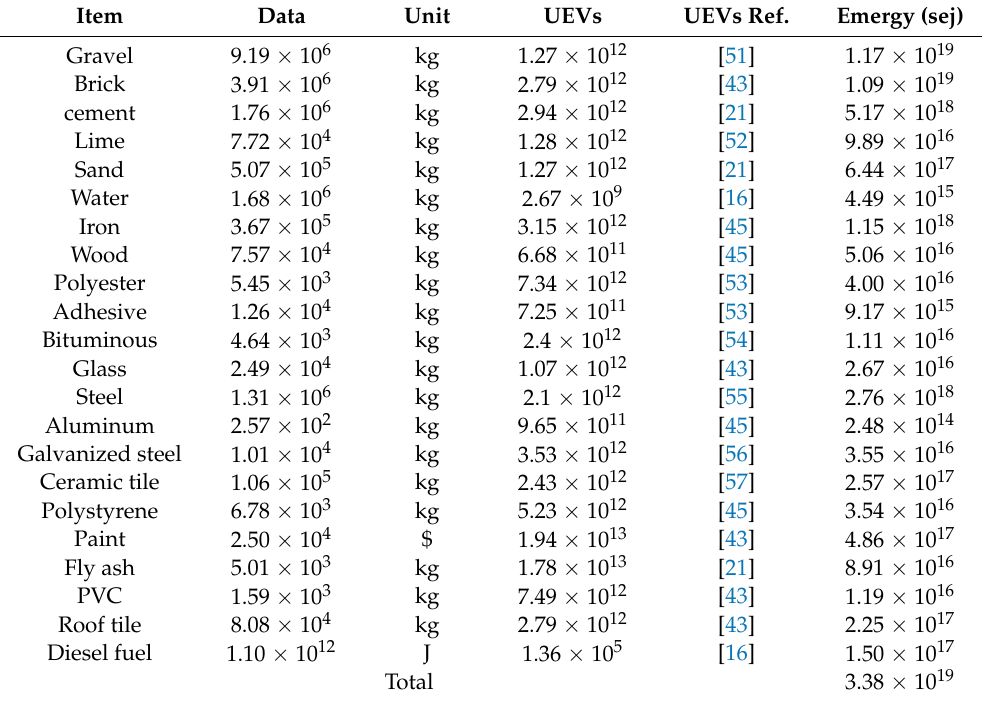
Table 2. Emergy table of Building materials.